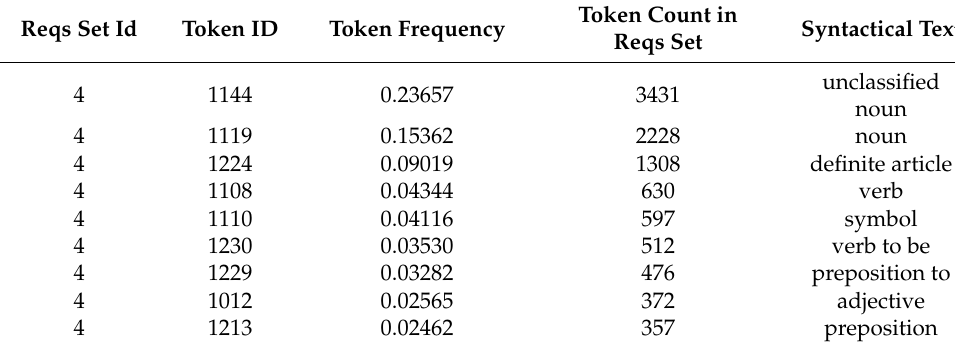
Table 2. Sample of the table of tokens with relative frequency in a specific RS.